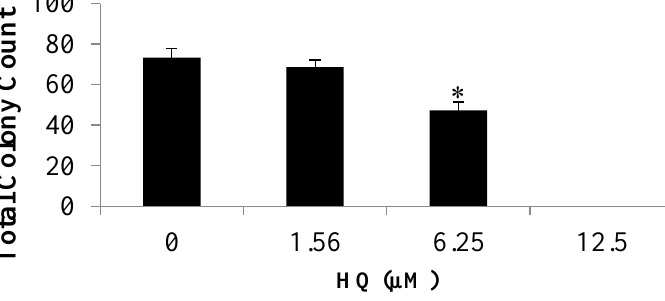
Figure 3 The effect of HQ exposure on the number of colony-forming units (CFUs) of myeloid-committed progenitors. The mouse bone marrow cells were exposed to HQ for 24 h at 1.56 µM, 6.25 µM and 12.5 µM. The number of CFUs was counted under inverted microscope after 14 days of culture. Data are presented as the mean ± S.E.M. (n=3). * p < 0.05 as compared to non-treated control group. 3.3